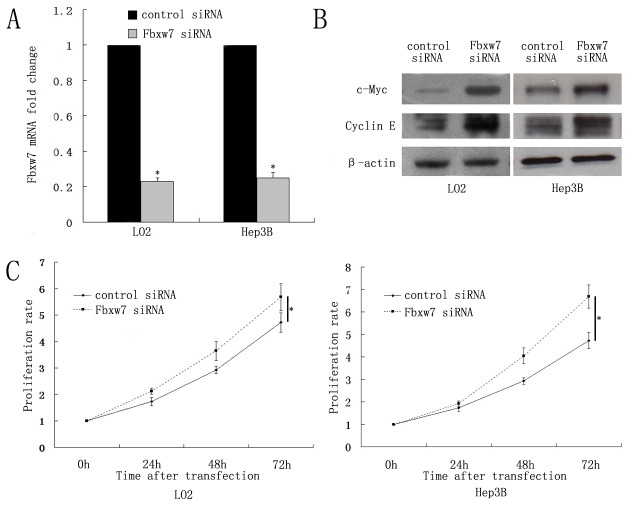
Effect of Fbxw7 knockdown on LO2 and Hep3B cell lines. A) qRT-PCR confirmed knockdown in LO2 and Hep3B cells treated with Fbxw7 siRNA. B) Expression of c-Myc and Cyclin E proteins were enhanced by Fbxw7 siRNA, as confirmed by Western blot analysis. β-actin served as loading control. C) Proliferation rates were assessed by MTT assay. Cell viability was normalized to time point 0 h. The proliferation rate of LO2 and Hep3B cells treated with Fbxw7 siRNA was significantly greater than in control siRNA cells. Values are depict as mean±standard error, n=3. *P<0.05 vs control siRNA.